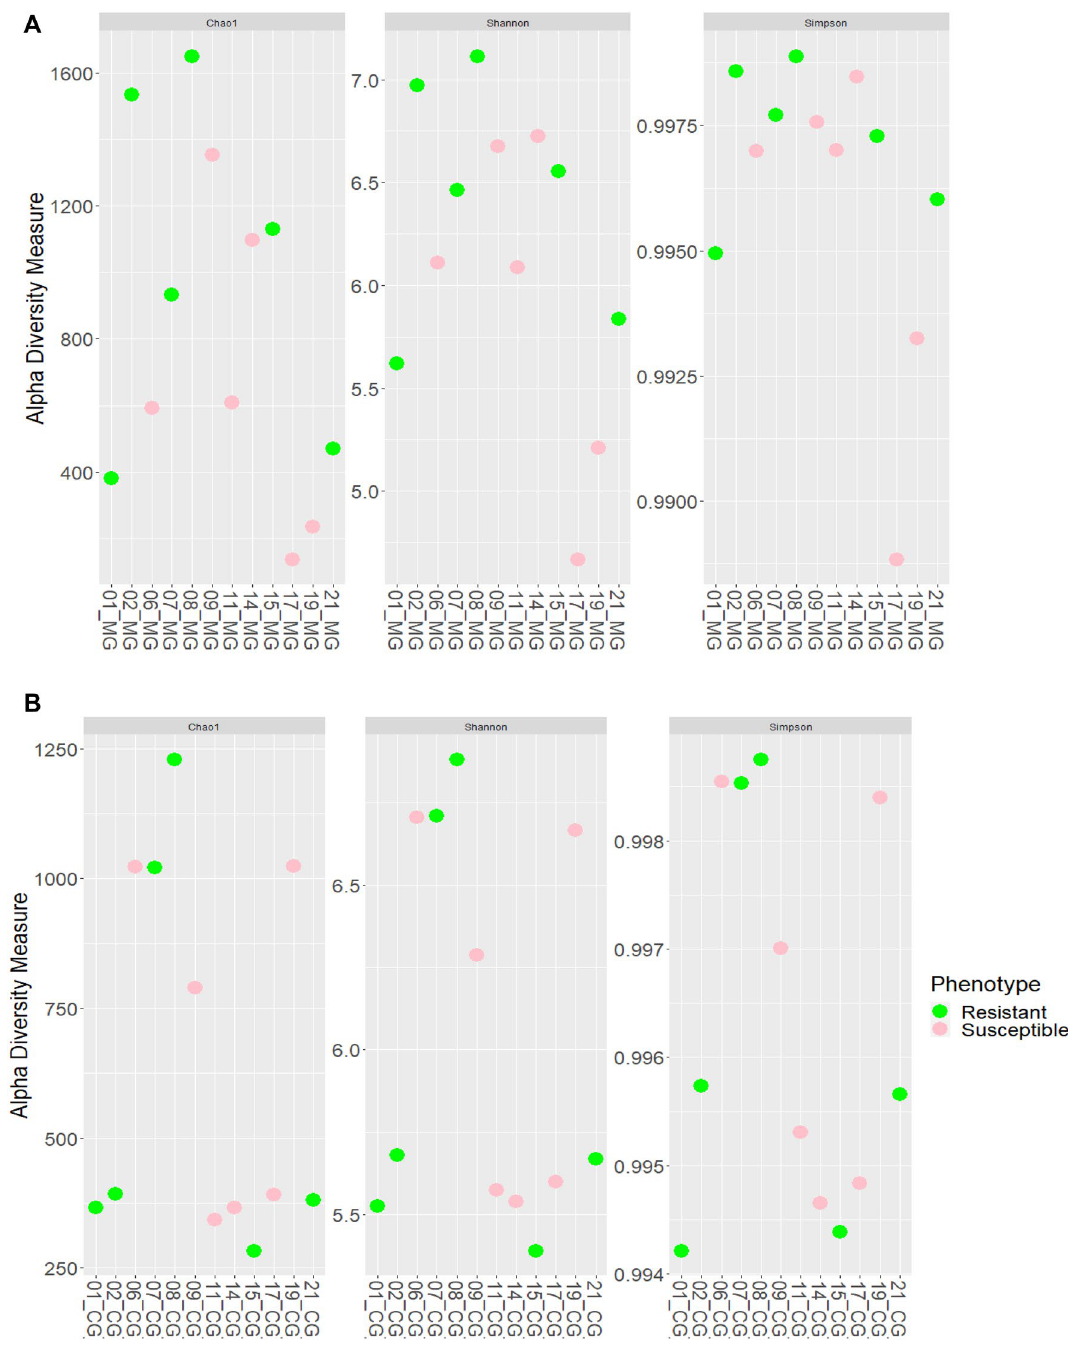
Figure 4. Estimation of richness (Shannon and Chao indexes) and evenness (Simpson index) in gastric mucosa ( A ) and gastric content ( B ) in RG (green) and SG (pink) experimentally infected with T. circumcincta. Not significance differences detected between